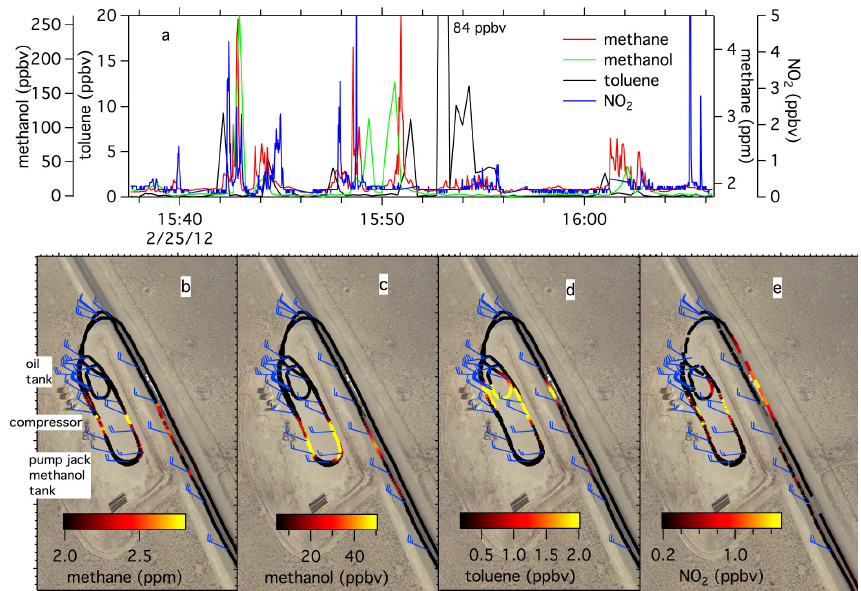
Figure 6. The drive track close to an oil well color coded with methane (b) , methanol (c) , toluene (d) and NO 2 (e) . The wind barbs indicate the prevailing wind direction. The time series for this period is shown in (a) .